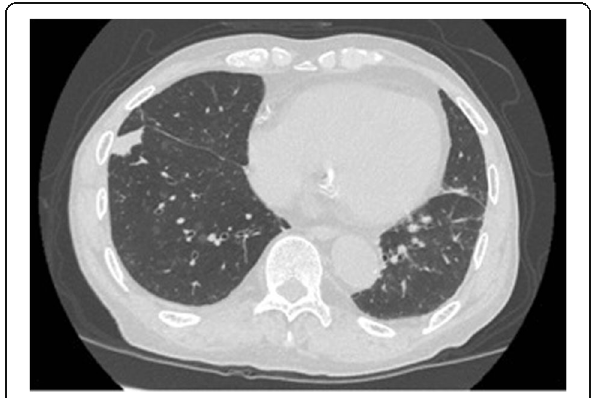
Fig. 2 Deployment of the artificial valve at TAVI Fig. 3 Chest CT scan before